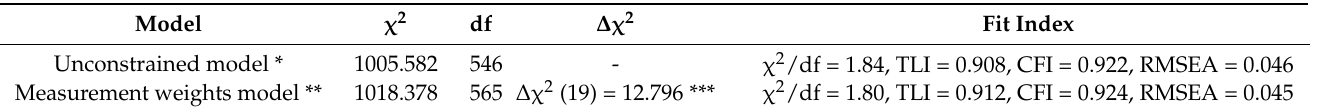
Table 6. Measurement equivalence analysis result.